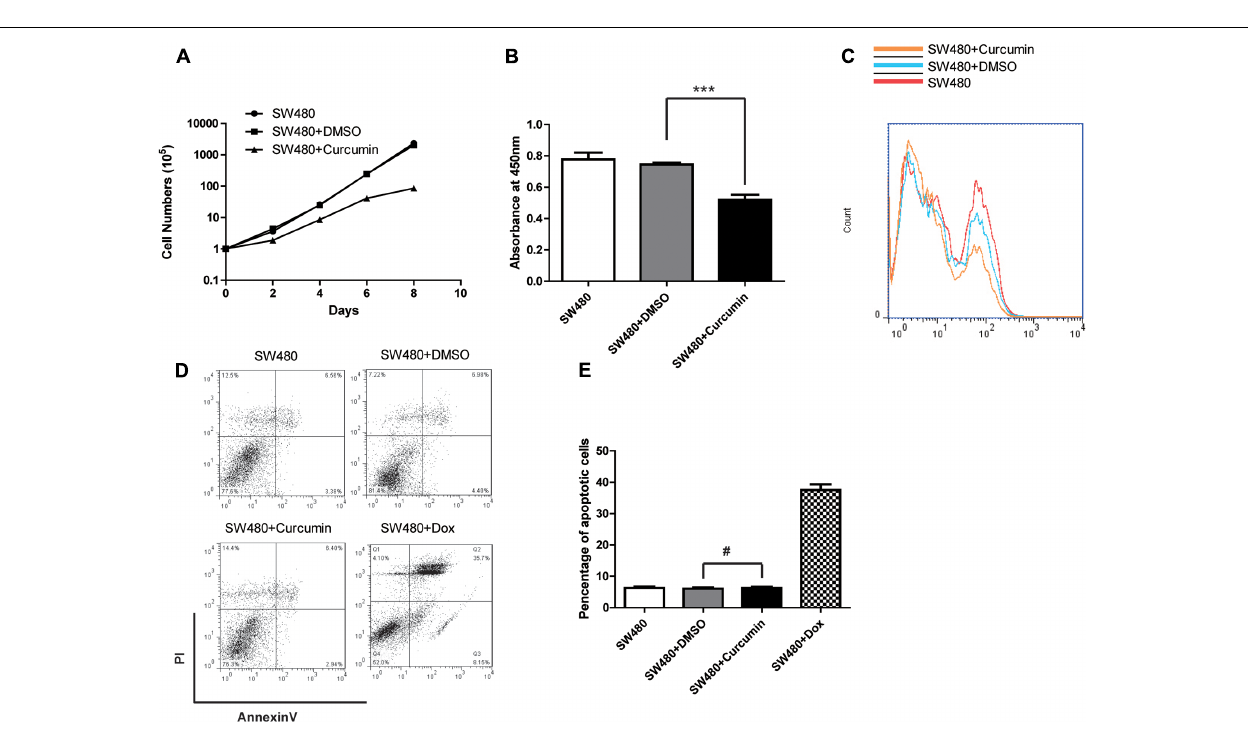
FIGURE 1 | Curcumin suppressed colon cancer. (A) Tumor generated by SW480 with different treatment as indicated was measured in diameters and calculated to volume according to the time point. n = 20 for each group. (B) Survival curve of the mice treated with curcumin or DMSO. Each group contains 20 mice.